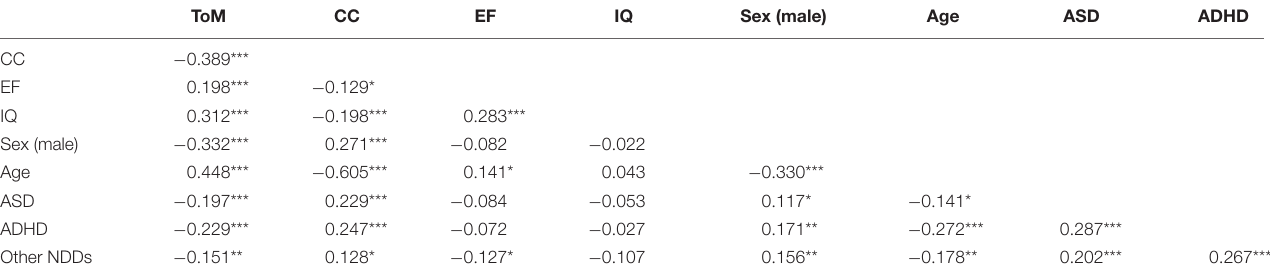
TABLE 2 | Correlations between cognitive functions, sex, age and NDDs.